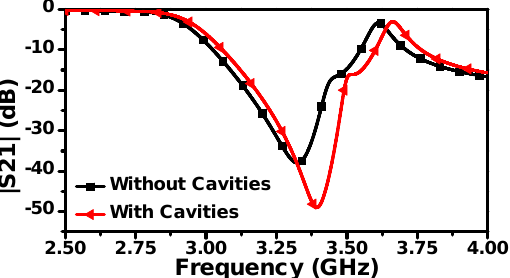
Figure 4. The scattering parameter | S 21 | dB of a three-resonator system with and without the aluminum